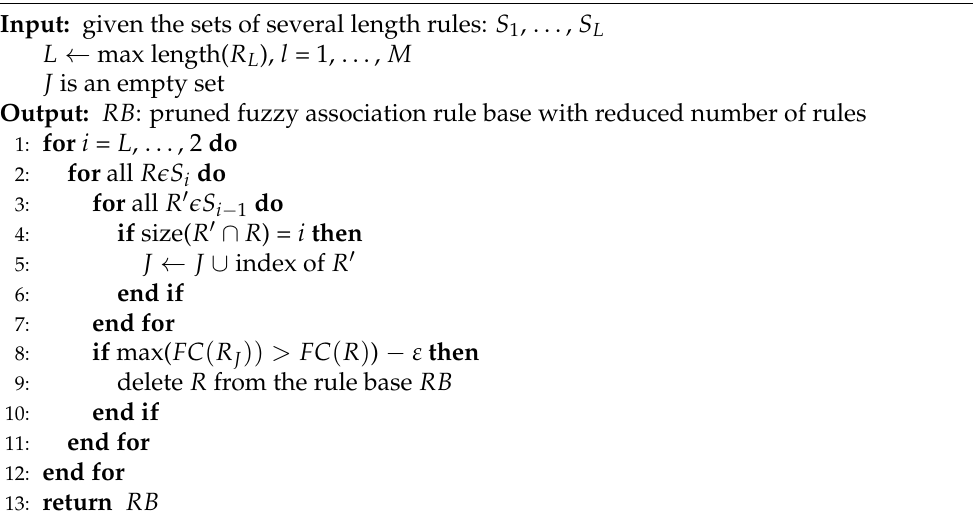
Algorithm 2 Algorithm of Fuzzy Association Rule Pruning Based on